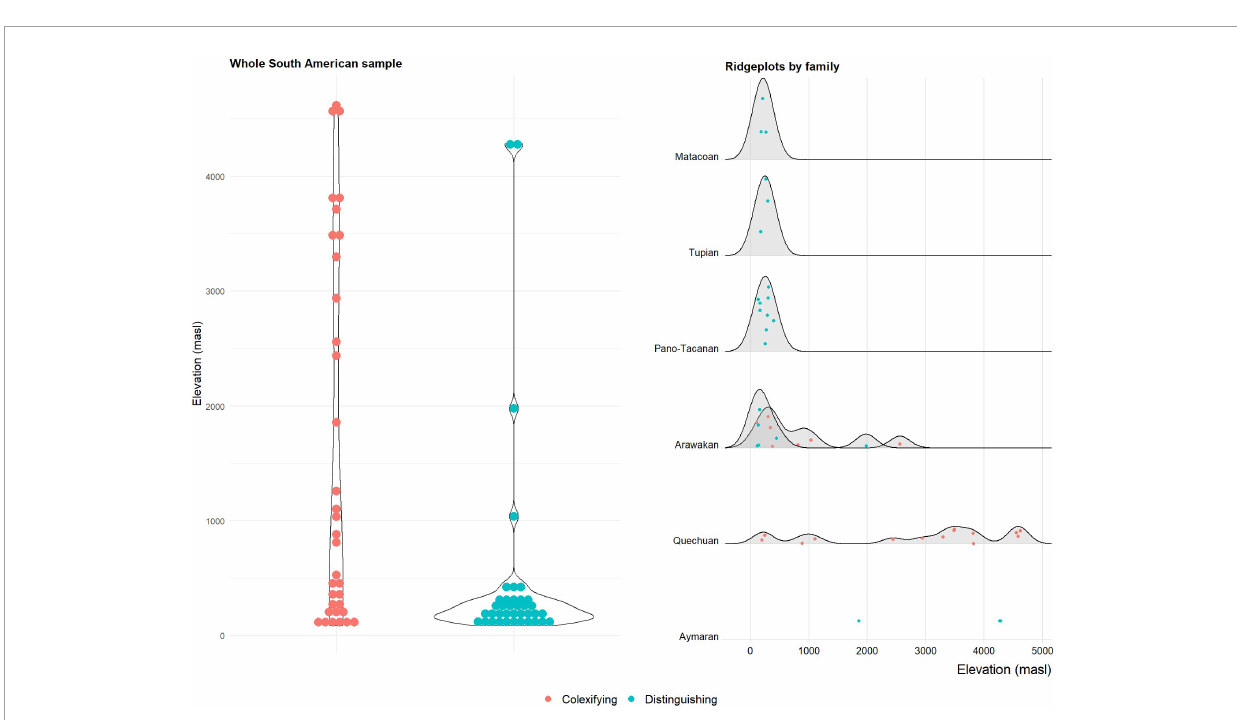
FIGURE2 Colexification and non-colexification of “cloud” and “fog” in languages of the Central Andes, depending on elevation.